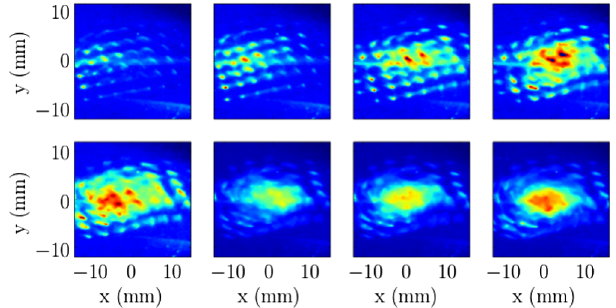
FIG. 9. TBF evaluated at its lowest-frequency maximum versus bunch charge for the three cases of solenoid settings displayed in Fig. 8 with corresponding beamlet spacing d (a) and for the case of a solenoid field of 290 A with associated beamlet spacing of d ¼ 10 mm (b).